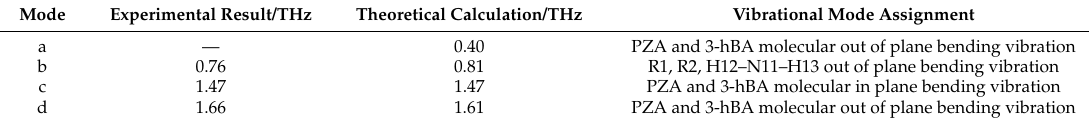
Figure 4. Vibrational modes description of cocrystal between PZA and 3-hBA at 0.40 ( a ); 0.76 ( b ); 1.47 ( c ); and 1.66 ( d ) THz. Table 1. Vibrational modes assignment of cocrystal between PZA and 3-hBA.